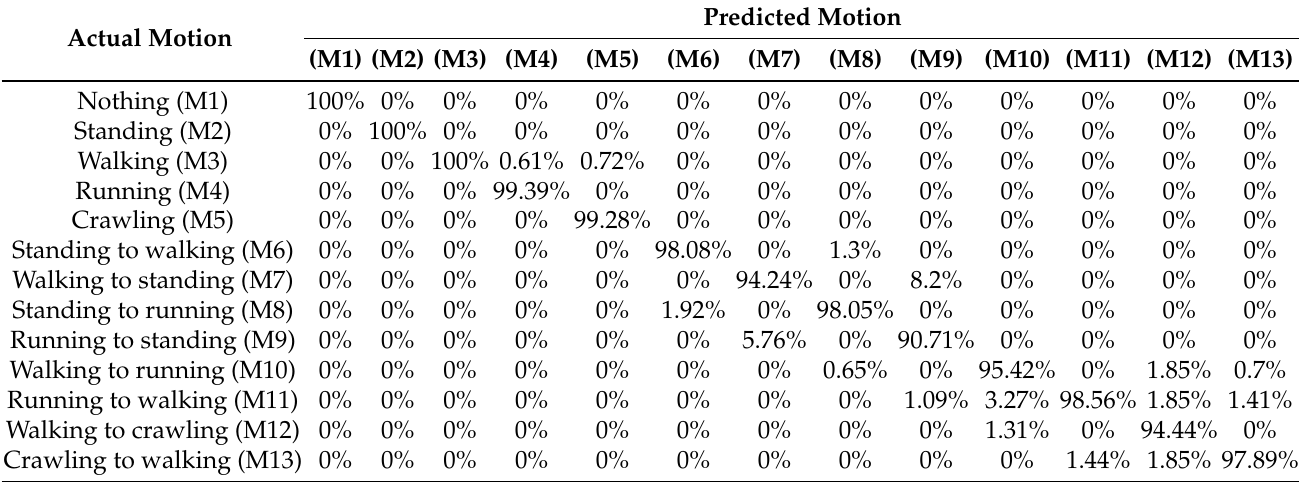
Table 4. Classification results from the CNN-based classifier (Case